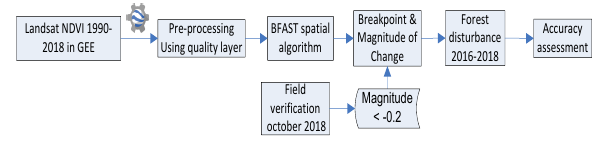
Figure 2. the general workflow of the forest disturbance detection and